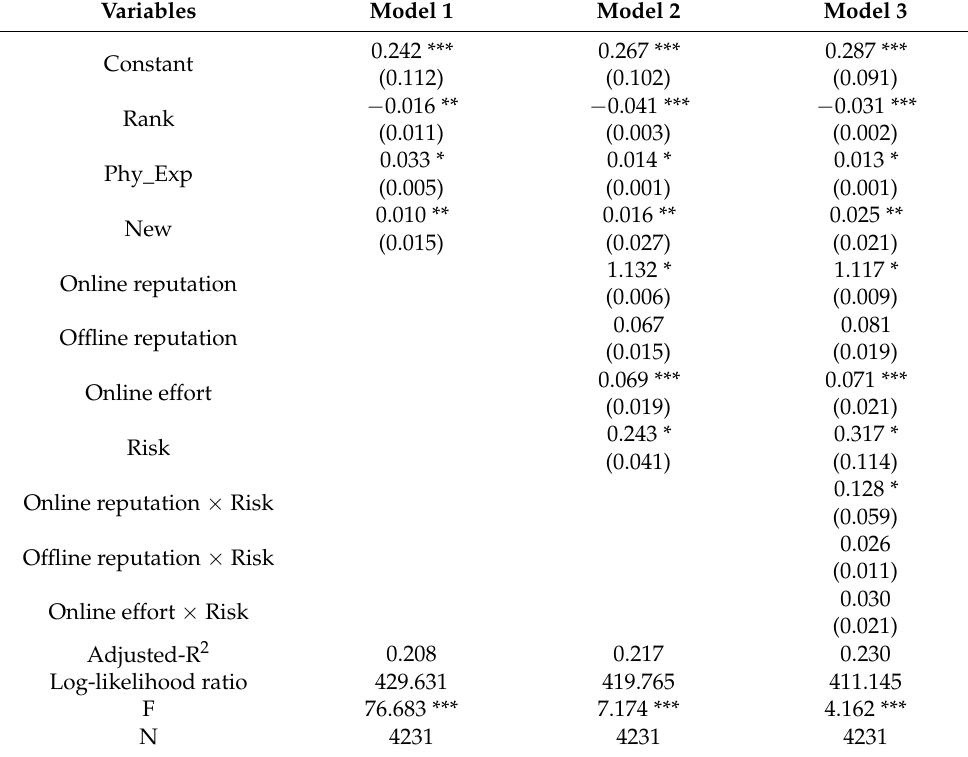
Table 3. Regression